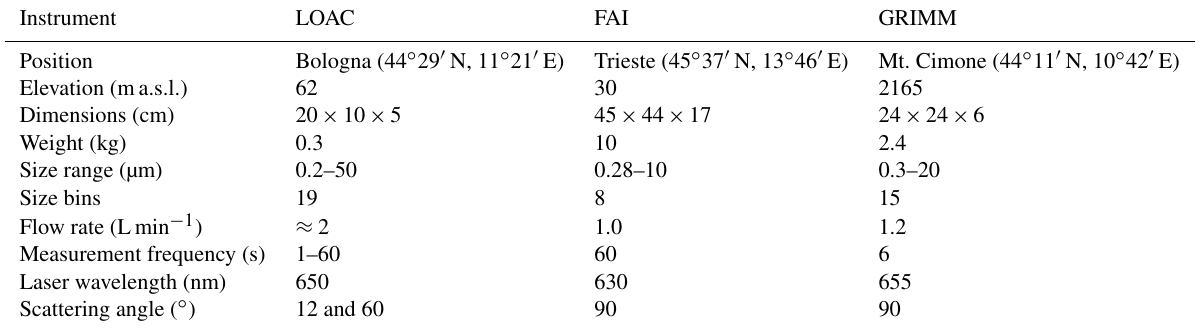
Table 1. Technical specifications of the three OPCs used: a LOAC instrument from Meteomodem, a multichannel monitor from FAI Instru- ments, and a GRIMM 1.108 instrument from